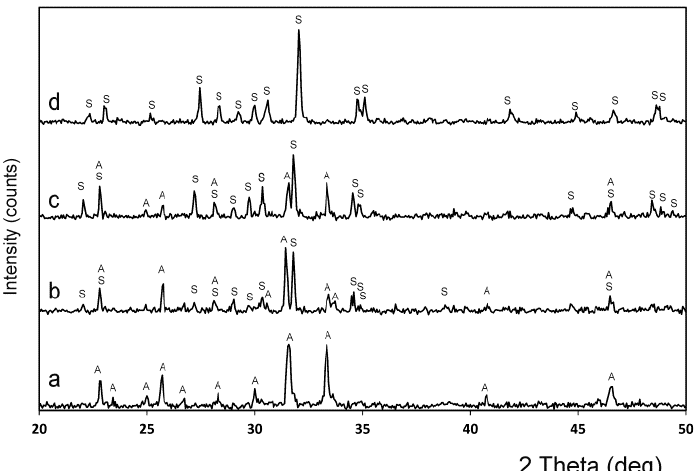
Figure 5. XRD patterns of samples ( a ) 90.48 wt % A/9.52 wt % S; ( b ) 84.57 wt % A/15.43 wt % S; ( c ) 13.60 wt % A/86.40 wt % S; and ( d ) 7.69 wt % A/92.31 wt % S. All of them heated at 1350 °C. (S: silicocarnotite ss , A: Nurse’s A-phase ss ; R: ( α -C 2 S- α ´TCP) ss ).